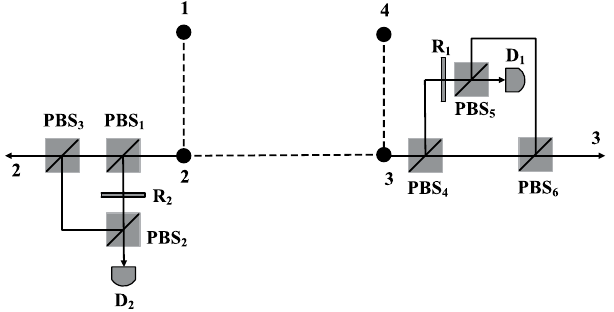
Figure 1. Schematic drawing of ECP for a four-particle cluster state with linear optics. PBS represents a polarizing beam splitter, which transmits the particle in the horizontal polarization | H 〉 and reflects the particle in the vertical polarization | V 〉 . R i represents a wave plate which can rotate the vertical polarization | V 〉 with an angle θ